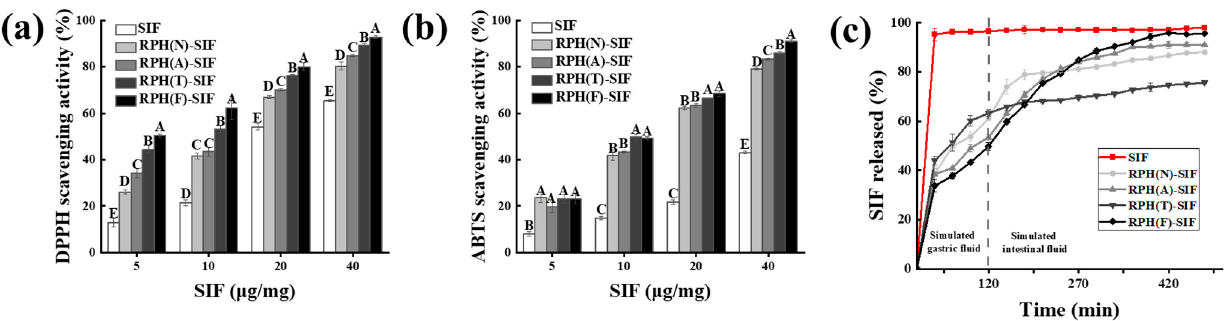
Figure 6. DPPH ( a ) and ABTS scavenging activities ( b ) of free and encapsulated SIF. ( c ) Release percentage of SIF in RPHs during in vitro digestion. A–E Di ff erent superscript le tt ers represent a sig- ni fi cant di ff erence ( p < 0.05).